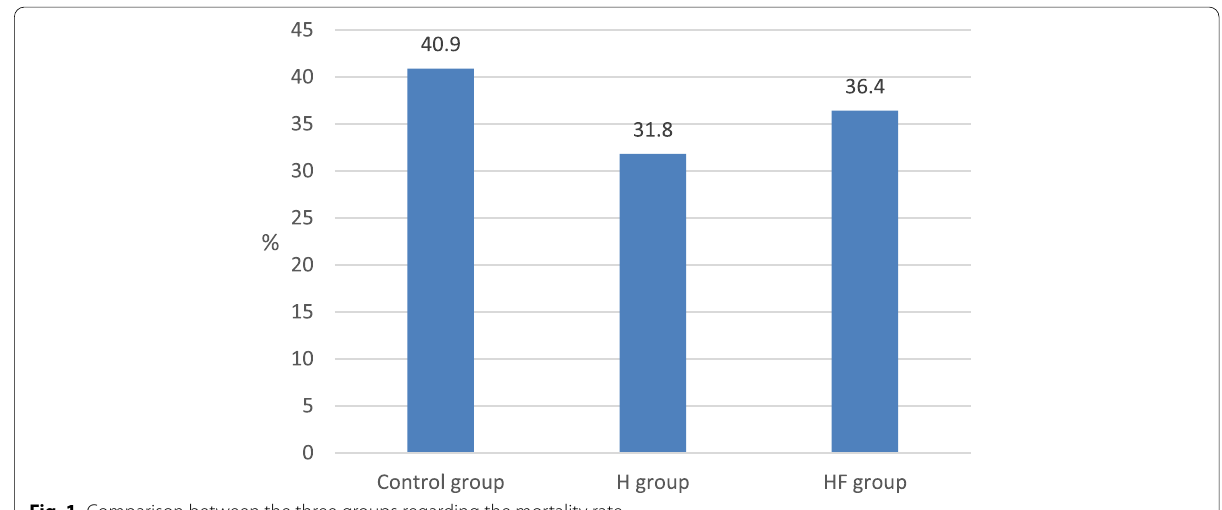
Fig. 1 Comparison between the three groups regarding the mortality rate